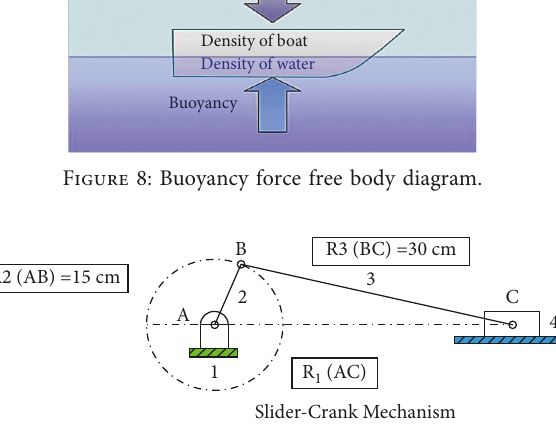
Figure 9: Slider-crank mechanism free body diagram.